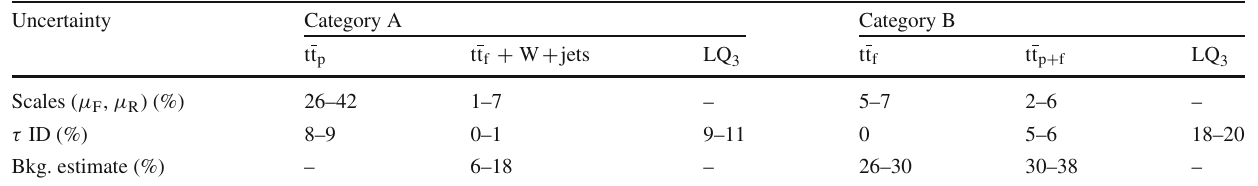
of700GeV. Shown are theranges ofuncertainties,whicharedependent on the search regions and the lepton channel type